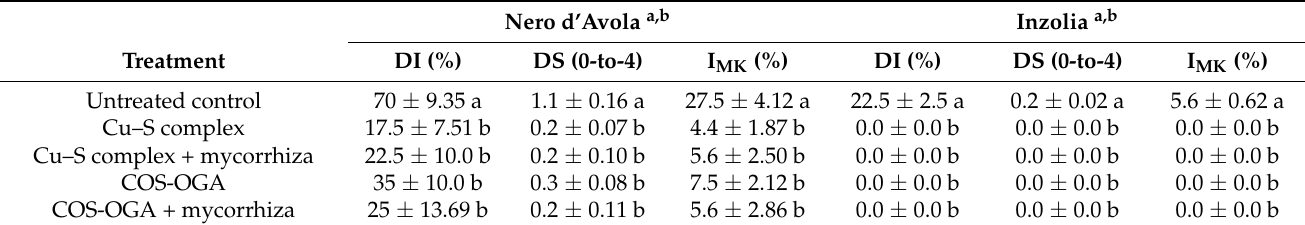
Table 4. Post-hoc analyses of treatment effects on disease incidence (DI), severity (DS) and McKinney’s index (I MK ) of gray mold caused by Botrytis cinerea on Nero d’Avola and Inzolia wine